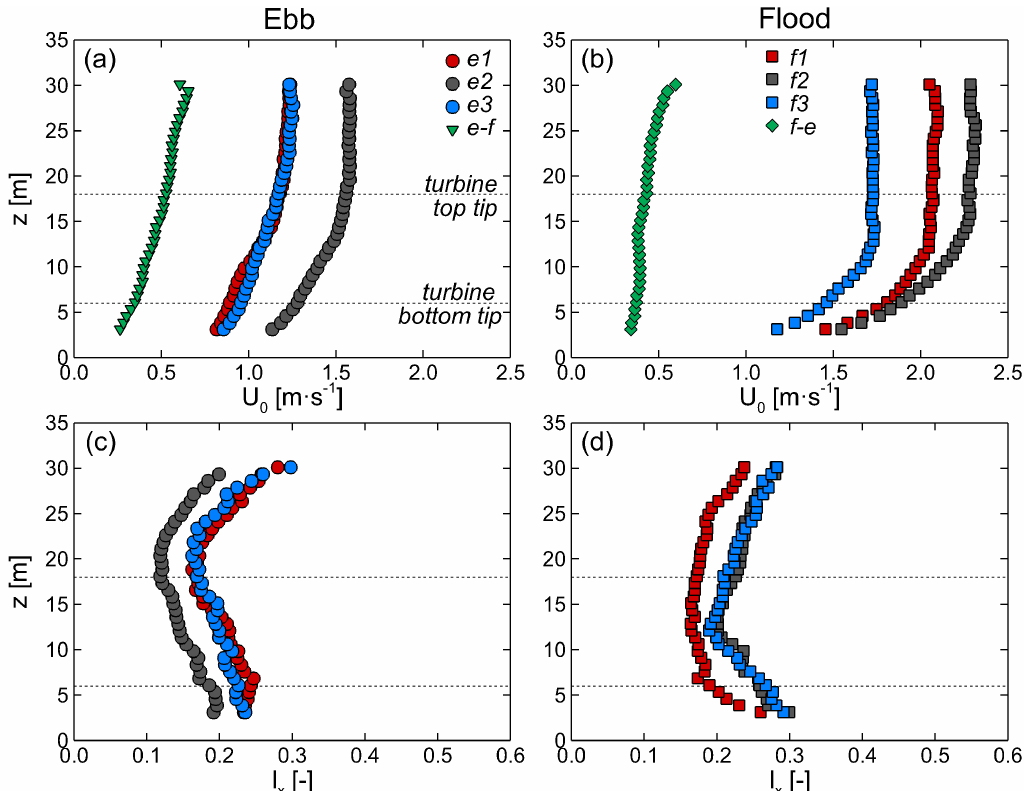
Figure 8. Vertical profiles of velocity ( a , b ) and turbulence intensity ( c , d ) averaged over 10 min at three selected time instances during ebb ( e 1, e 2 and e 3) and flood ( f 1, f 3 and f 3) tides and transition from ebb to flood ( e − f ) and flood to ebb ( f − e ). Dashed lines indicate turbine top and bottom